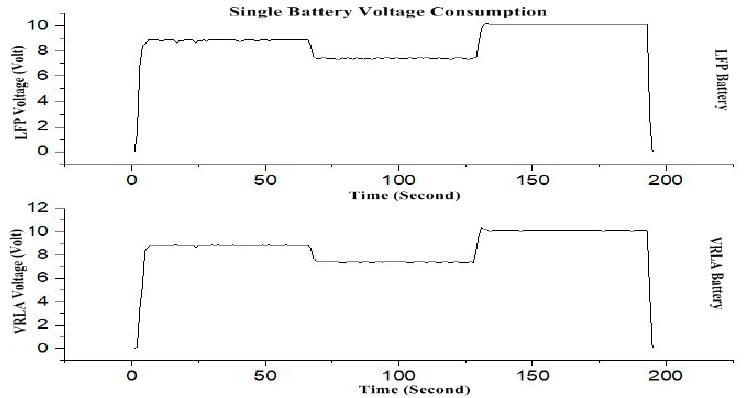
Figure 17. Single battery voltage consumption of VRLA and LFP graph.